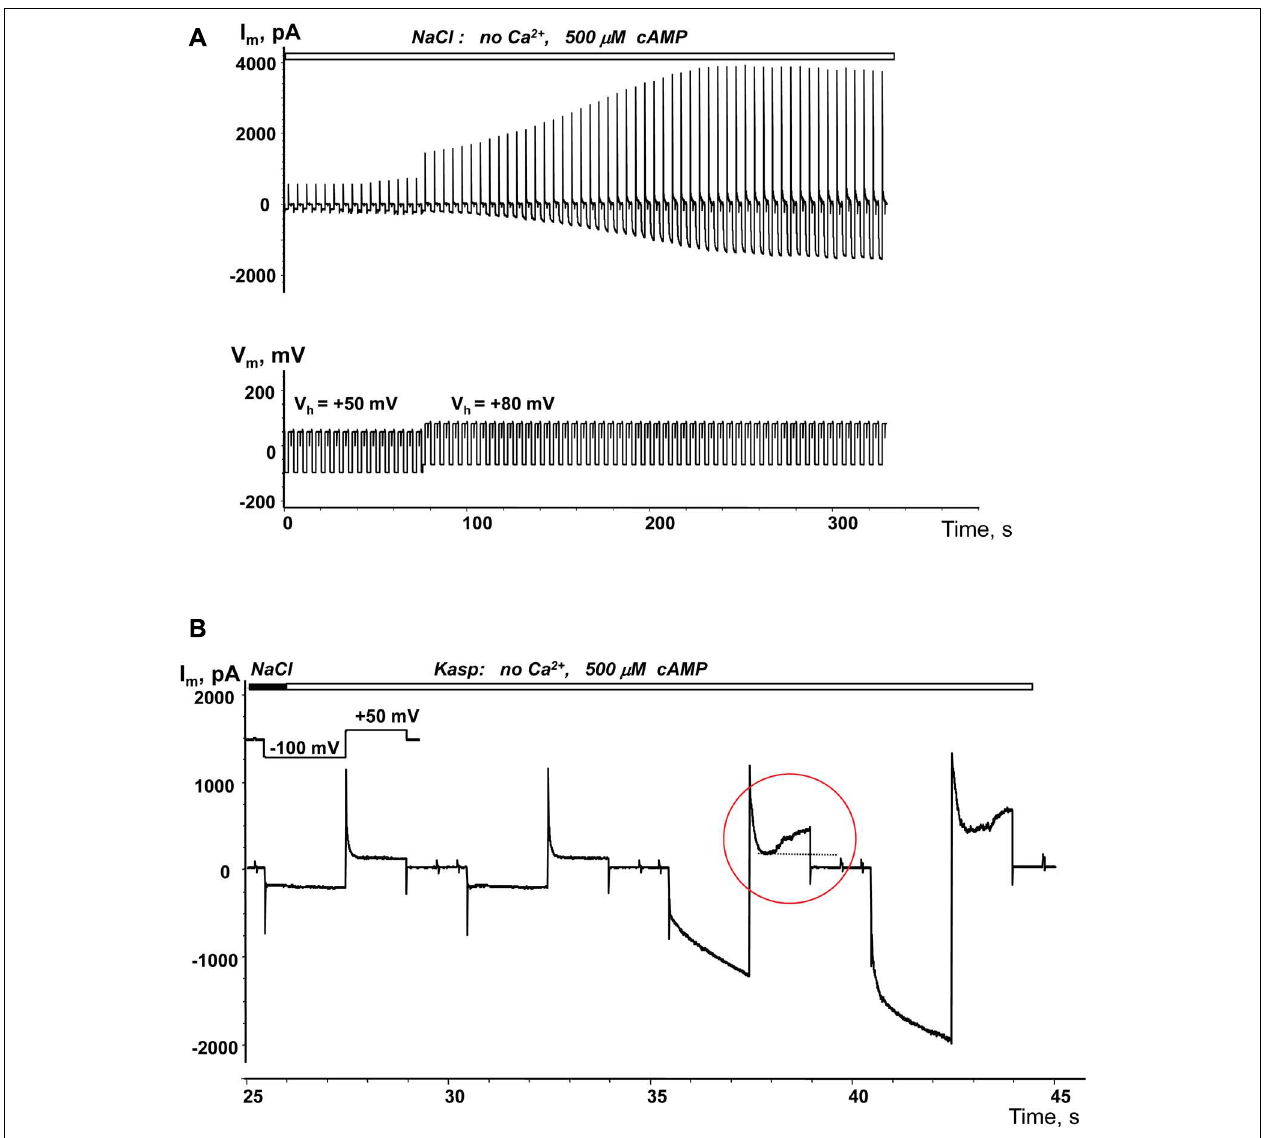
the SpIH current in a time dependent manner by ∼ threefold (when adjusted to the same V h ). (B) SpIH current recorded in a HeLaCx43/SpIH cell during perfusion with Ca 2 + -free KAsp solution.The SpIH current increase was associated with the time-dependent membrane current increase during depolarization (noted by a red circle), typical of hemichannel